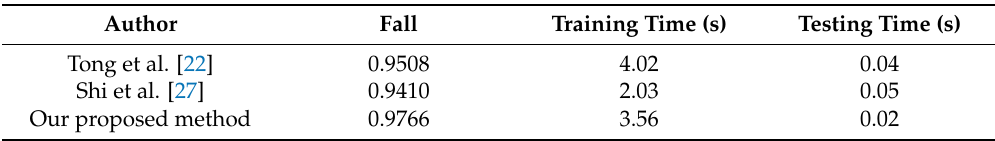
Table 7. Performance of the fall detection